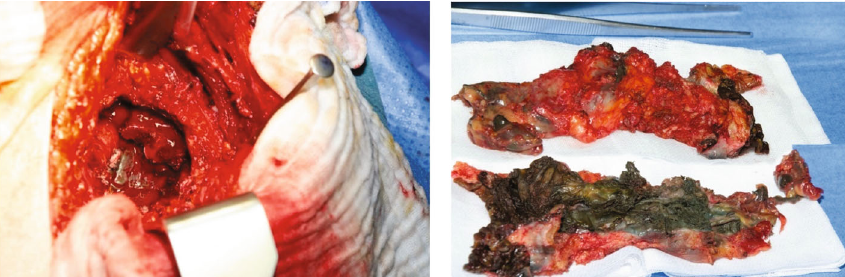
Figure 4: Metallotic pseudotumor. (a) shows the intraoperative metallosis with pronounced osteolysis. (b) shows the resected metallotic tissue after a complete surgical debridement.